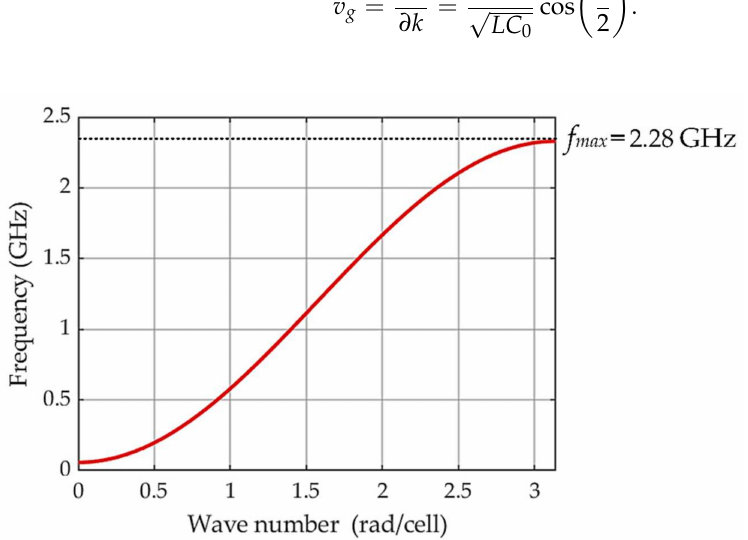
Figure 3. Dispersion curve of lossy NLTL for network parameters: C 0 = 9.8 pF and L = 2